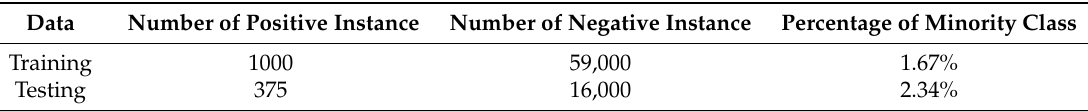
Table 3. Number of instances and percentage of minority class in training and testing data of air pressure system (APS) failure